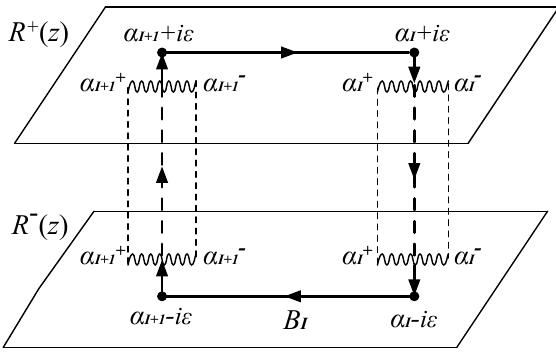
Figure 16 . Computation of B cycle